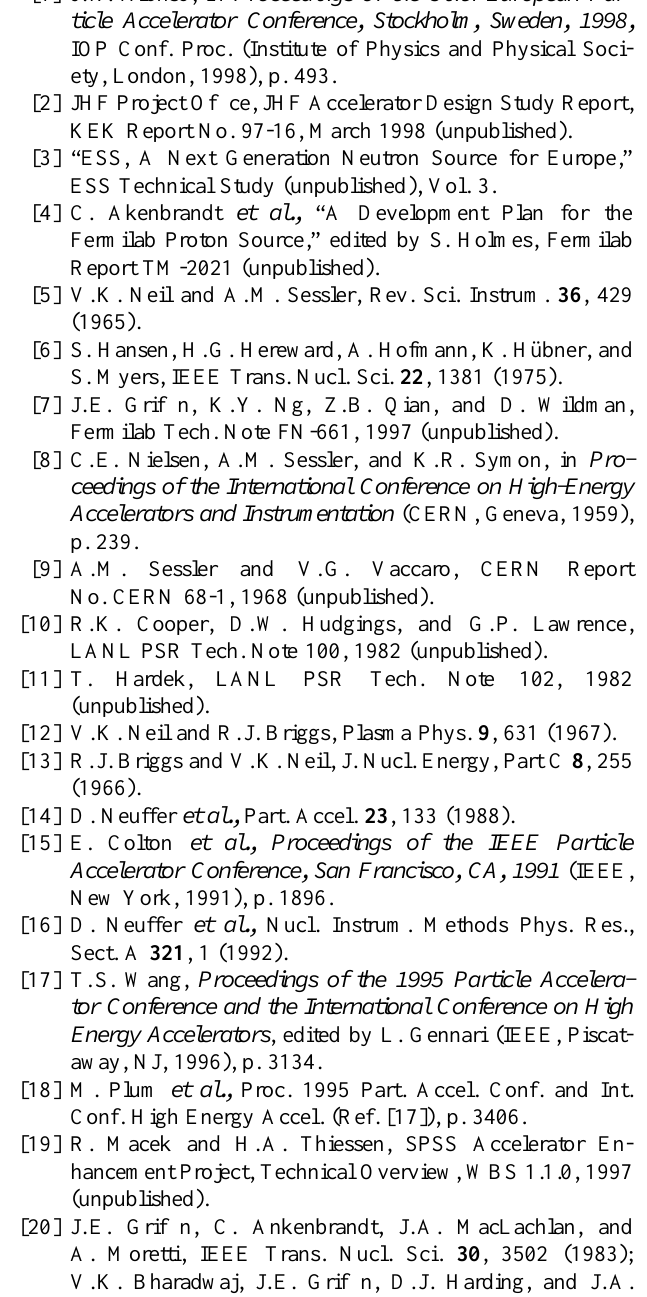
FIG. 10. Inductor module impedance (total of both cavities) from MAFIA